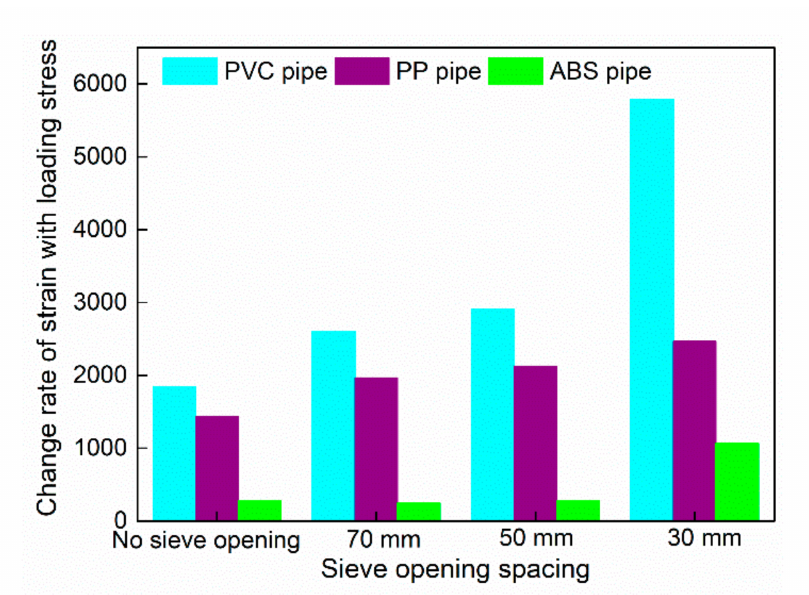
Figure 9. Change rate of strain with loading stress under different screen opening spacings.